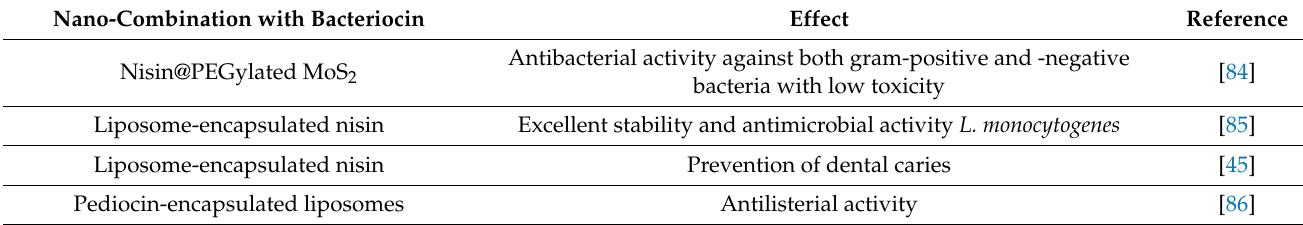
Table 2. Biomedical applications of nano-combination with